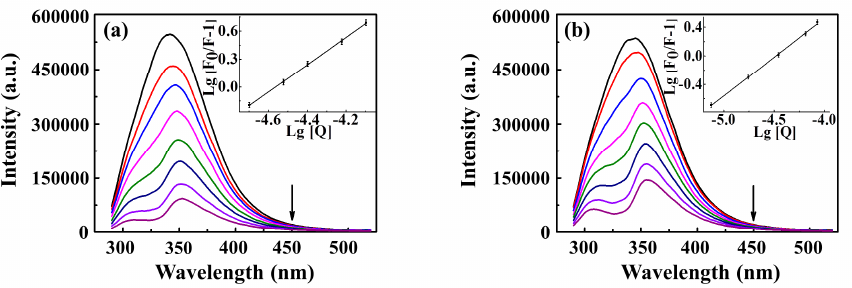
Figure 4. Fluorescence emission spectra of human serum albumin (HSA) (10 µ M) titration with the increasing concentrations (0–80 µ M) of two complexes ( a ) Ru-Lbpy 1 and ( b ) Ru-Lbpy 2 . The excitation wavelength is 280 nm, pH 7.5, 298 K. The inset represents Stern–Volmer plot of HSA quenched by complexes, lg [F 0 /F-1] vs. lg [Q].